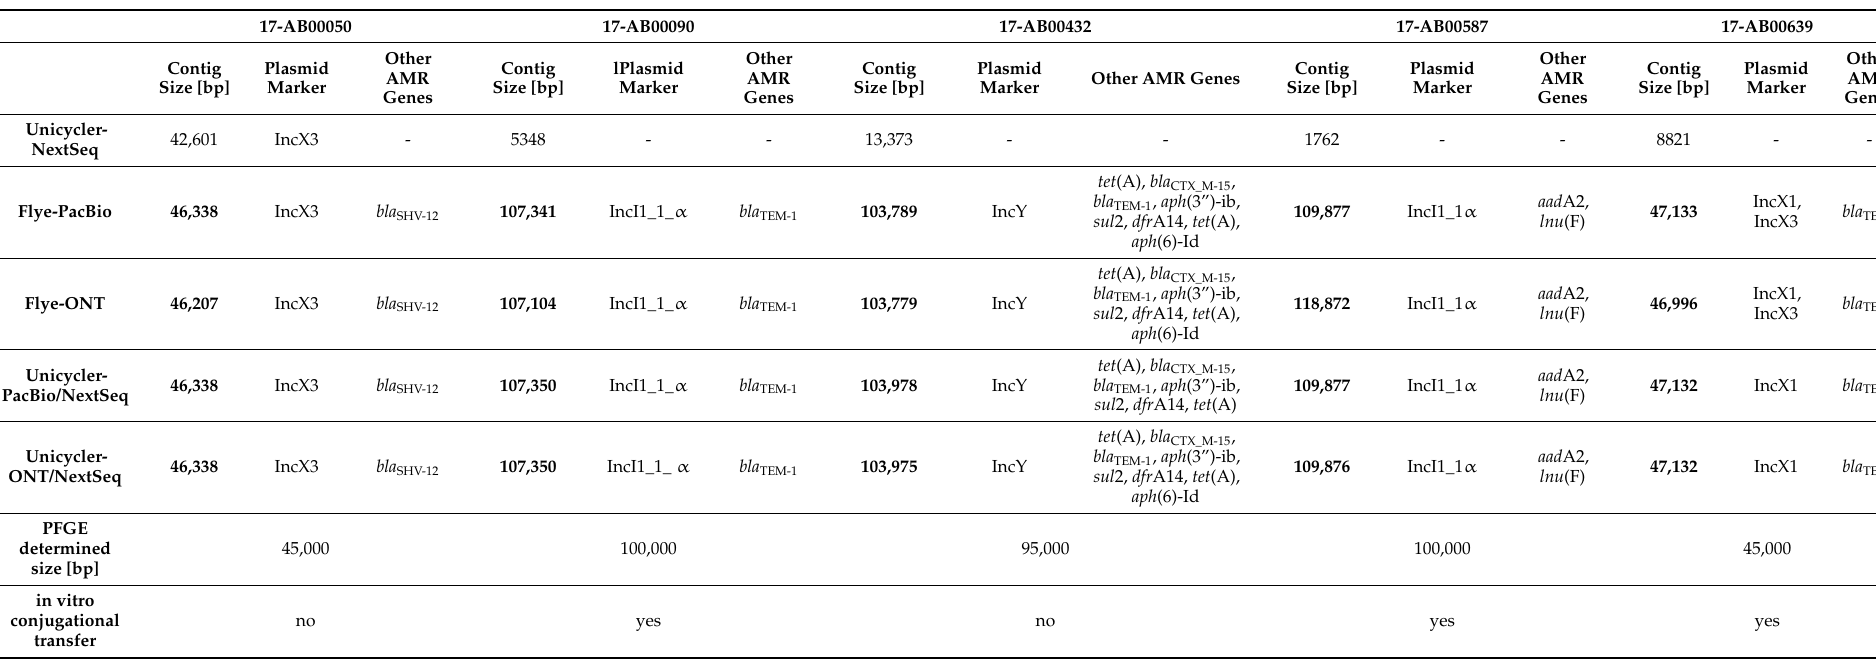
Abbreviation: AMR, antimicrobial